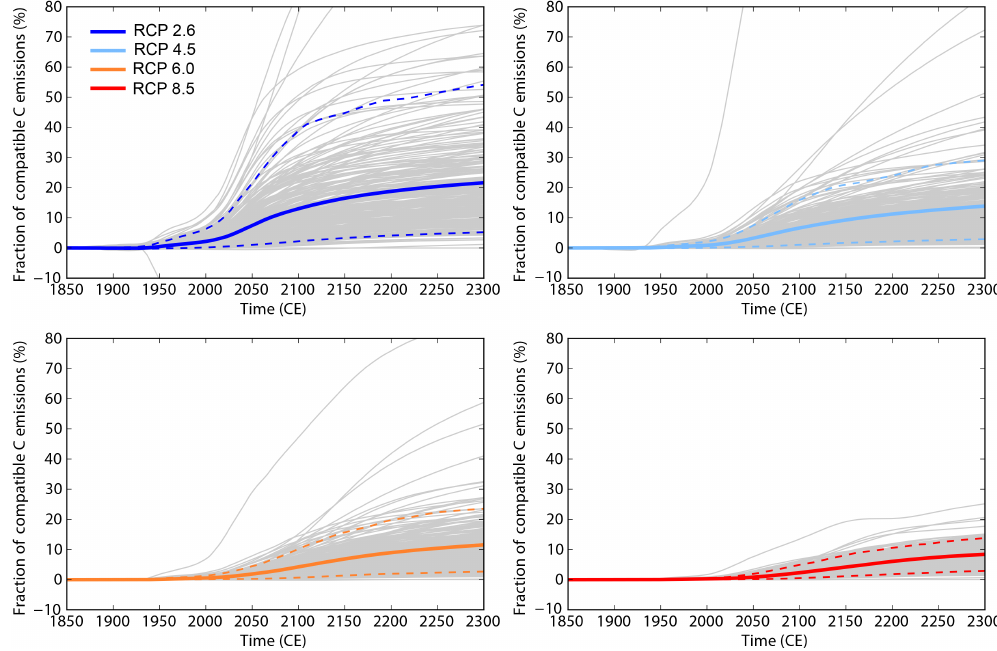
Figure 5. Cumulative emissions from permafrost soils relative to diagnosed compatible emissions for each model variant (grey lines) and each RCP scenario. Mean for each scenario shown with think solid line. Fifth and 95th percentiles shown with dashed lines. Note that under scenarios with lower emissions permafrost carbon emissions are larger relative to fossil fuel emissions.